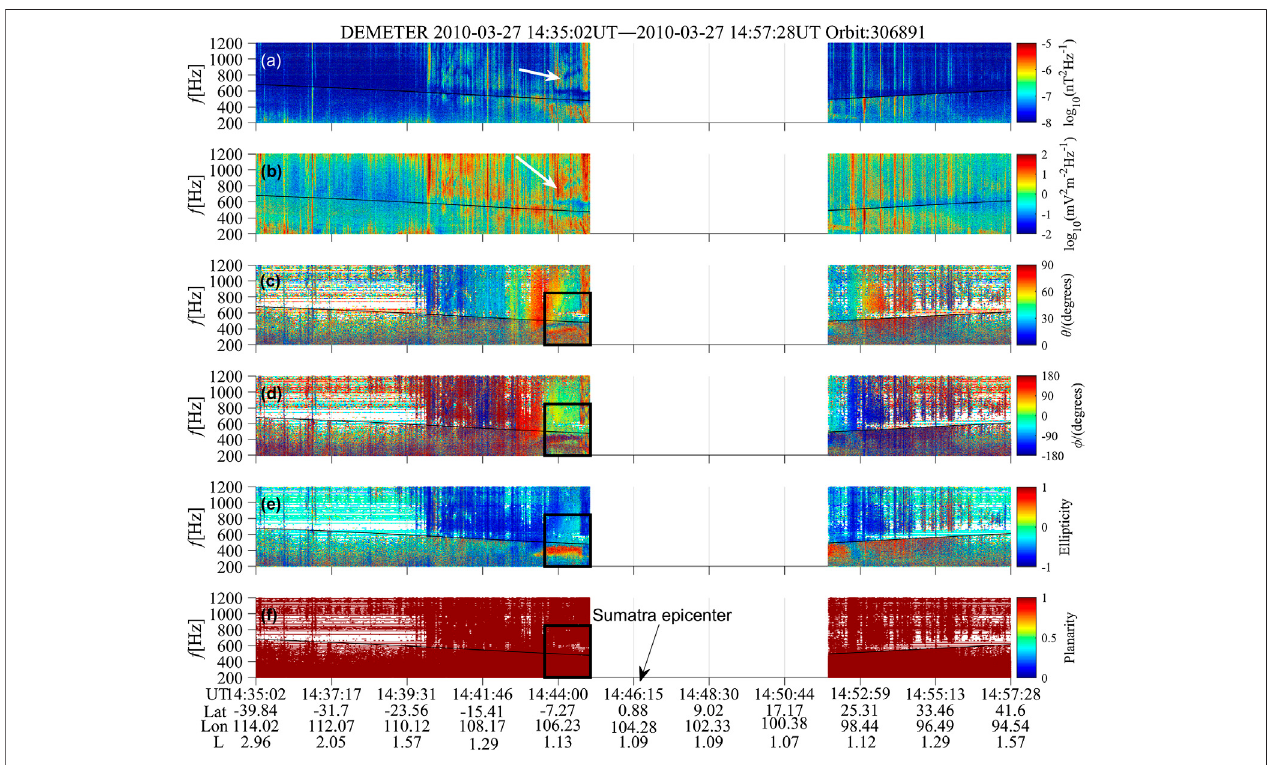
FIGURE 7 | The wave propagation parameters of extremely low frequency waveform recorded by orbit No. 306891. The black lines represent the local proton cyclotronfrequency. Fromtoptobottom: (A,B) thepower spectral valuesofmagnetic fi eldand electric fi eld, (C) thewavenormalangle θ ; (D) theazimuthal angles ϕ ; (E) the ellipticity, (F) the planarity. The arrow indicates the time of the orbit crosses the EQ epicenter. The black rectangular box denotes the abnormal waves near the epicenter area, which wave propagation parameters are statistically analyzed in Figure 8 .